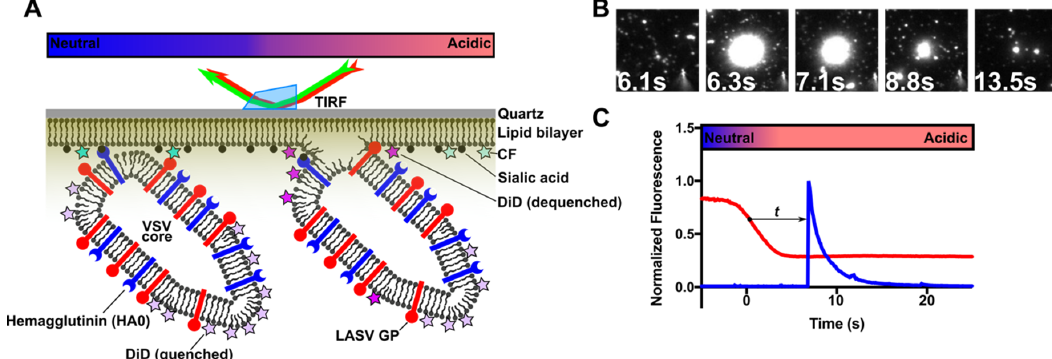
Figure 3. LASV GP mediates lipid mixing between fluorescently labeled virions and a supported lipid bilayer. ( A ) Cartoon of pseudovirions formed with a VSV core, inactive HA0, and LASV GP, hemifusing to a planar lipid bilayer supported by a quartz microscope slide within a microfluidic chamber. Pseudovirions were flowed onto the bilayer and allowed to attach at neutral pH by way of the HA0–sialic acid interaction. DiD fluorescence dequenching arose due to single pseudovirions hemifusing to the supported bilayer upon the introduction of acidic pH. CF was included in the supported bilayer in order to provide a fluorescence indicator of pH. Fluorescence was detected using the evanescent field generated from the simultaneous total internal reflection of 642-nm and 532-nm lasers on a custom-built prism-based TIRF microscope. Movies were recorded at a 100 ms exposure time (10 Hz) for a minimum of 1400 frames. ( B ) Frames from a single DiD dequenching event at pH 5 acquired at the indicated time points, where Time = 0 was defined as a 50% decrease in CF fluorescence. ( C ) Representative fluorescence traces (CF, red; DiD, blue) are from a single dequenching event. The drop in CF fluorescence arises from the acidification of the buffer in the channel. The subsequent spike in DiD fluorescence arises from dequenching as DiD diffuses into the planar bilayer. The interval ( t ) between the 50% decrease in CF fluorescence and DiD dequenching was extracted for kinetic analysis.